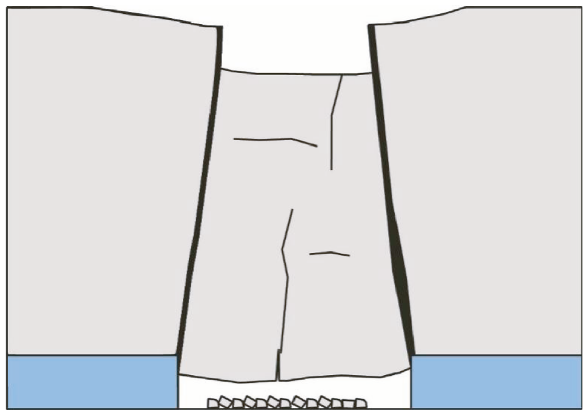
Figure 10: The plug subsidence of the overlying strata.